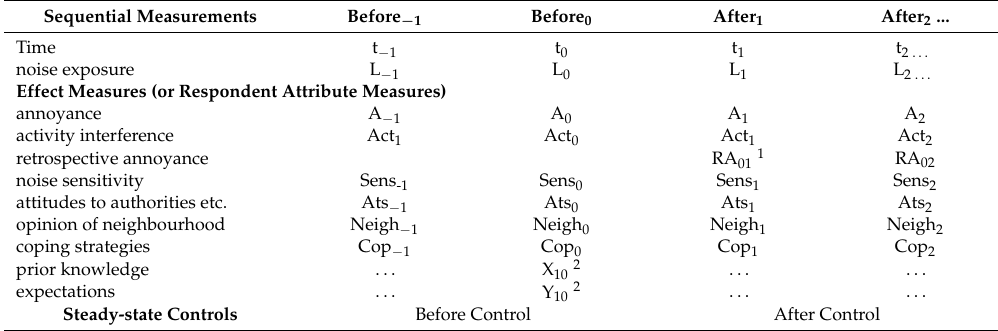
Table 20. Model protocol for intervention studies. After Brown (2015) [17]. Sequential